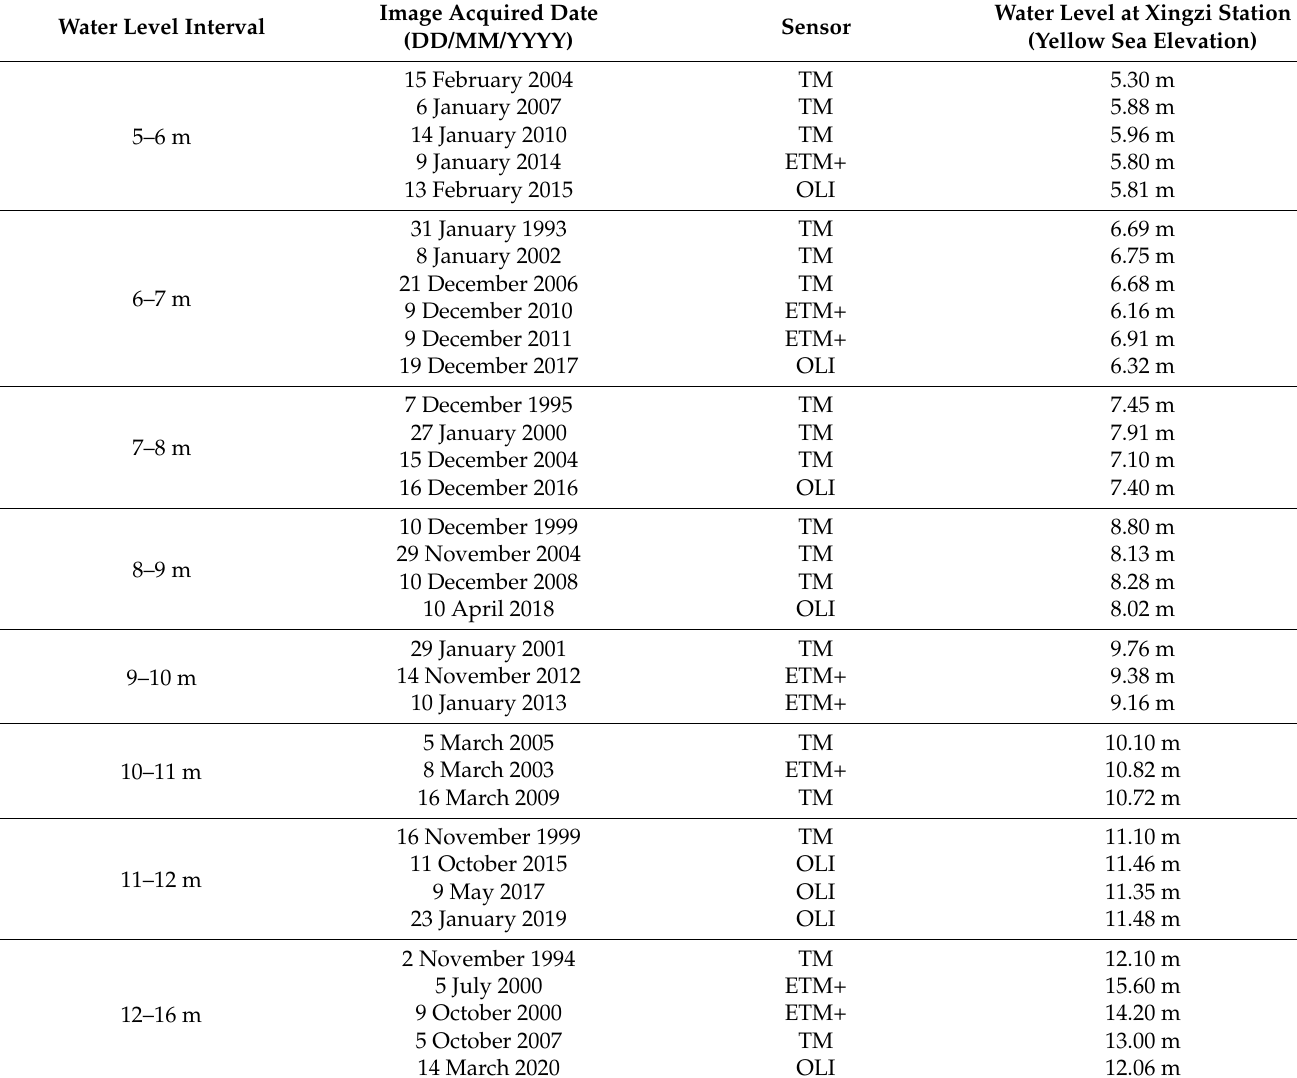
Table 1. Landsat TM/ETM+/OLI images used in this study and the corresponding water levels at the Xingzi gauging